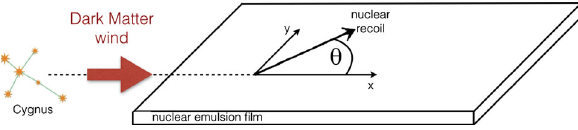
Fig. 1 The 2D reconstruction is performed in the xy -plane. The x - axis is directed opposite to the Cygnus constellation and θ is the angle between the x -axis and the projection of the nuclear recoil in the xy - plane